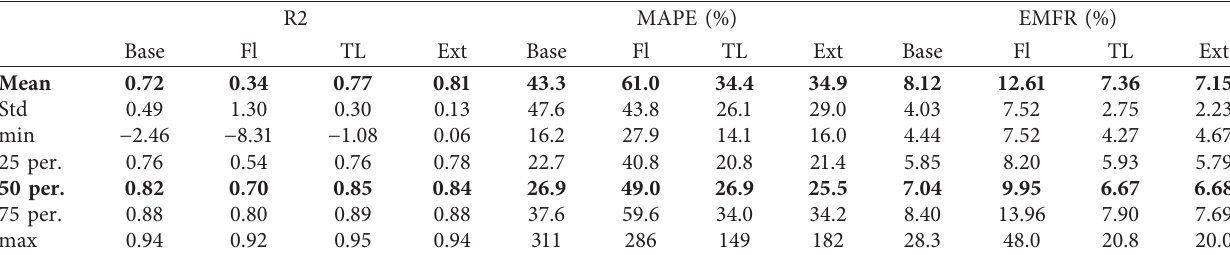
Table 2: The detailed results for different